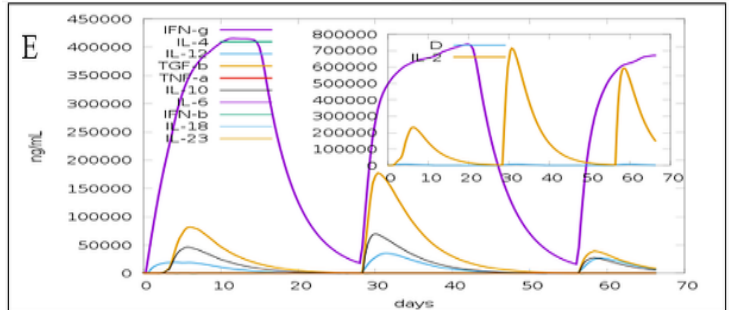
Figure 5. Immune profile of the fungal MEV candidate showing ( A ) antigen count and antibody titer with Ig subclass; ( B ) B-cell population; ( C ) plasma B-cell population; ( D ) T h population per state; ( E ) cytokines and interleukins population.